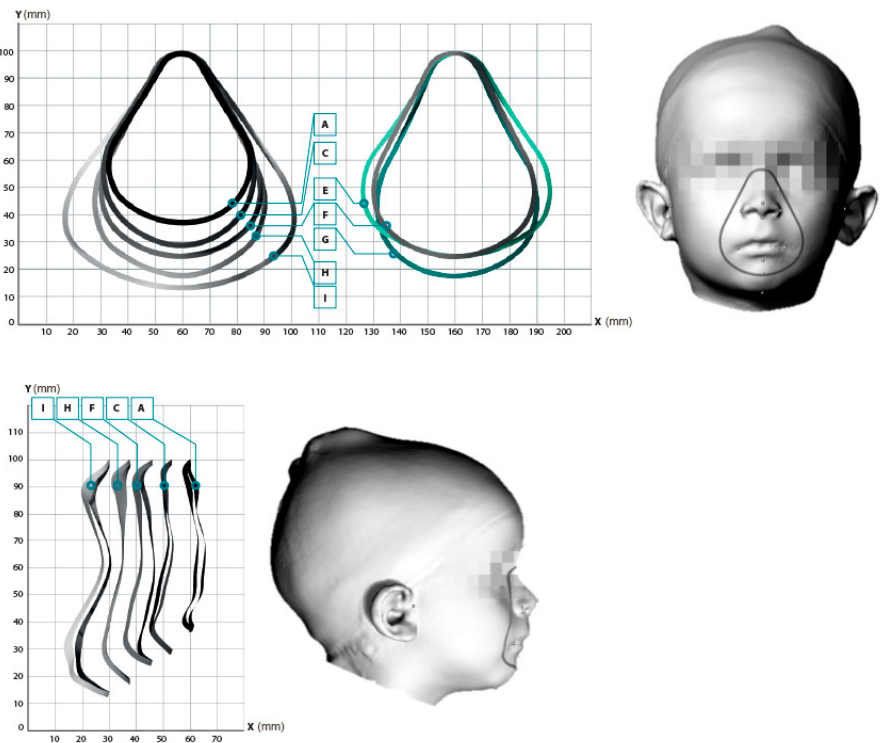
Figure 9. A comparison between contours of a facemask of children with different face shapes and sizes (mm). Lettering refers to the face examples as shown in Figure 8. Front view ( top ) and side view ( below ) and an example of a 3D scan with the contour projection (face example F).